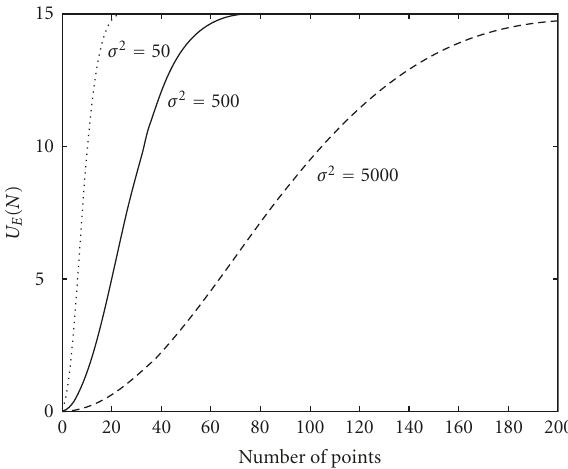
Figure 5: Maximum value of energy allowed for the curvilinear regions for di ff erent values of σ U and U = 15. N represents the number of points of the skeleton. The method can benefit the detection of longer regions using this function instead of a fixed threshold for the maximum value allowed for E Δ w